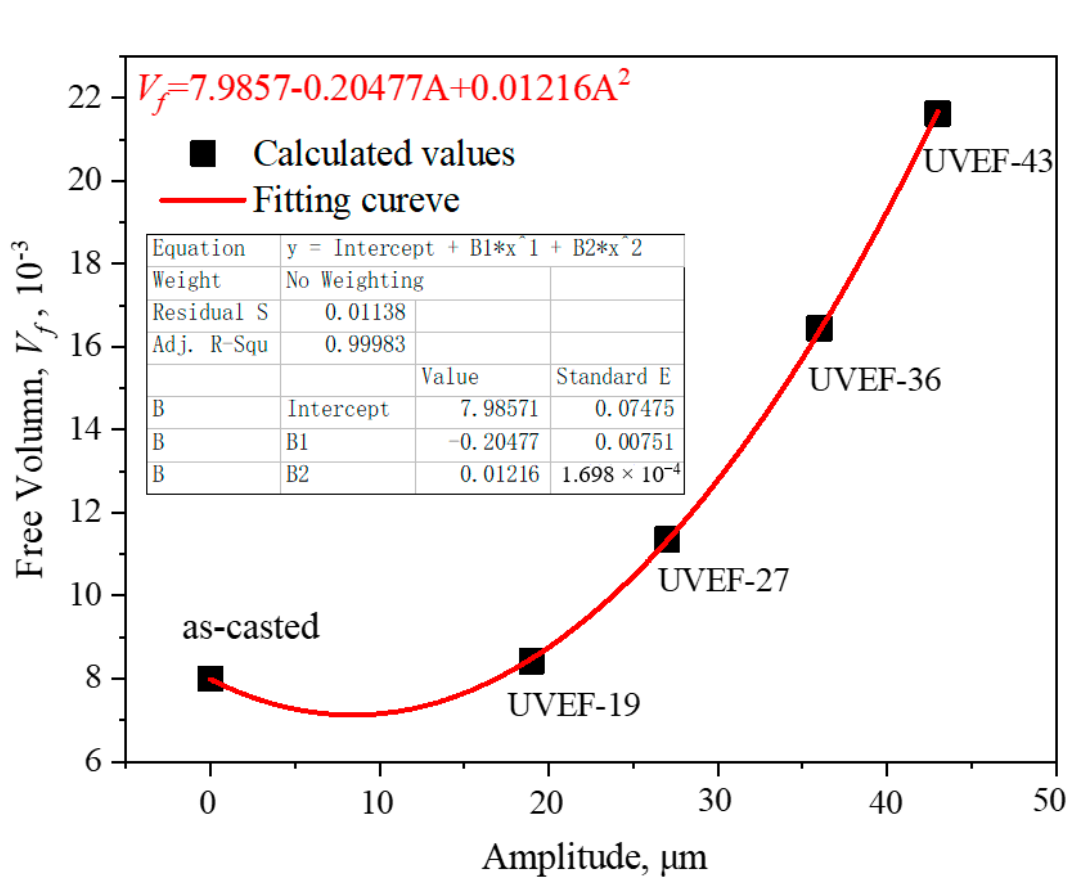
Figure 12. Theoretical model of the relationship between the free volume and amplitude of UVEF-treated